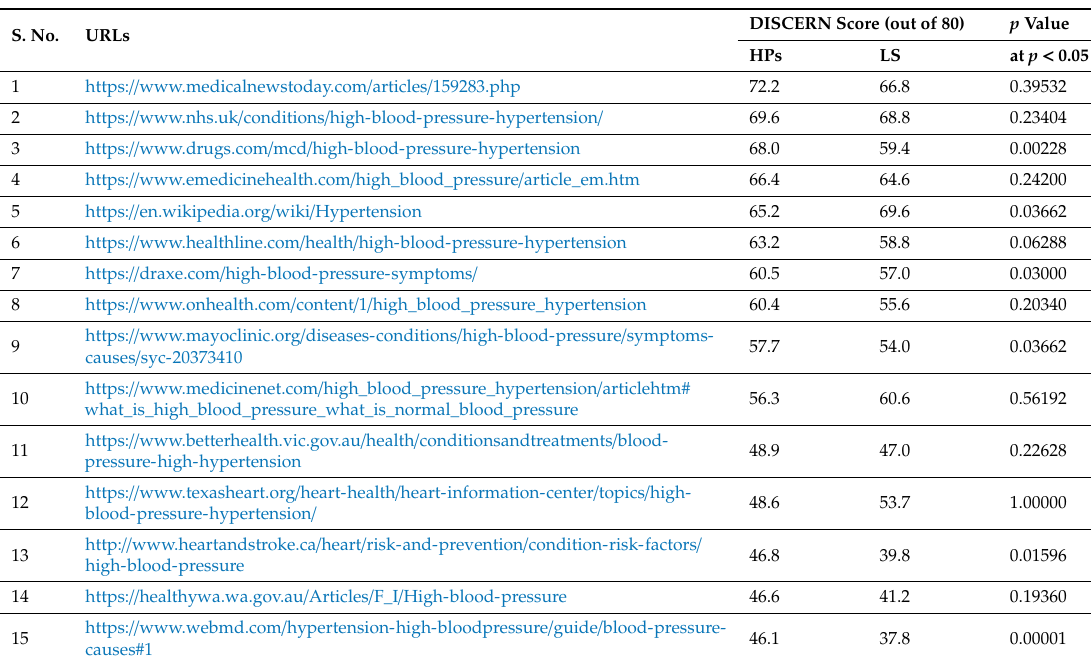
Table A3. DISCERN Score and p